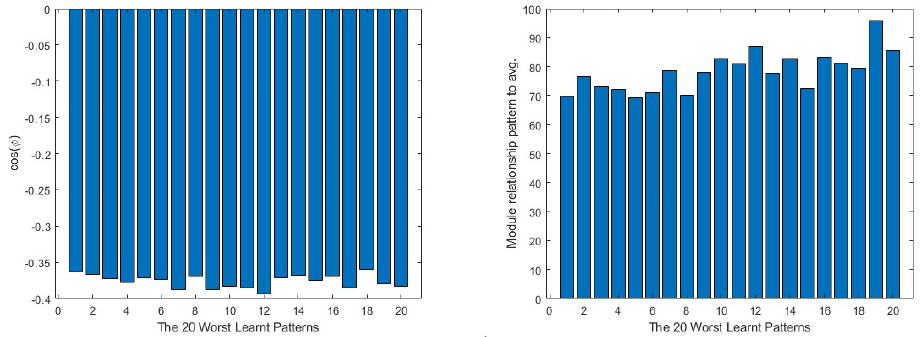
(cid:3339) (cid:12) (cid:12) (cid:4698) relationship to the av- (cid:3339) ∂ Loss µ (cid:12) (cid:12) (cid:4698) relationship to the av- (cid:3105)(cid:3024) (cid:3289) (cid:12) (cid:12) relationship to the ∂ W n (cid:3105)(cid:3024) (cid:3289)